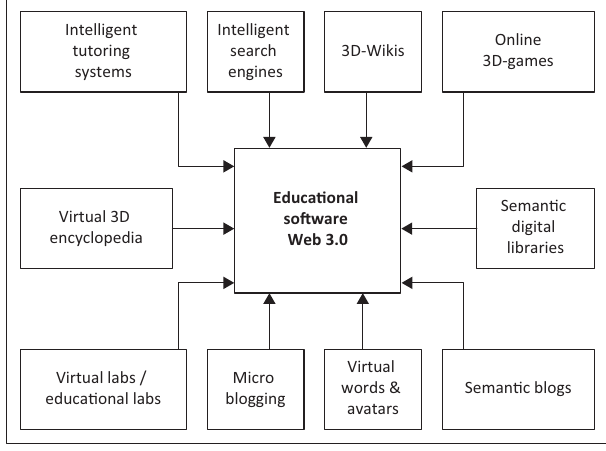
FIGURE 2: Educational web